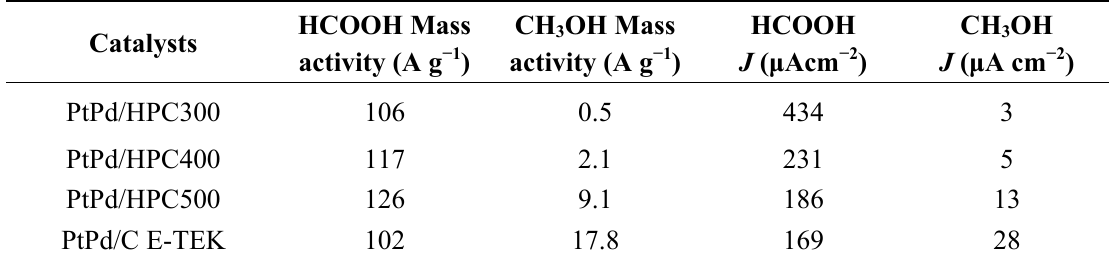
Table 2. Electrochemical characterization of the catalysts considering stationary values from current transients. (0.55 V ; 25 RHE